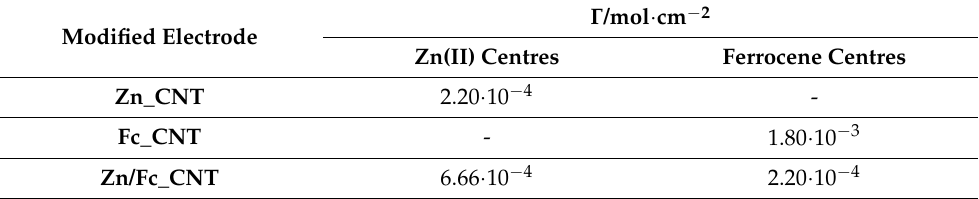
Table 2. CNT paste electrode surface coverage layers of Zn/Fe and Zn metallomesogens and ferrocene precursor ( S4